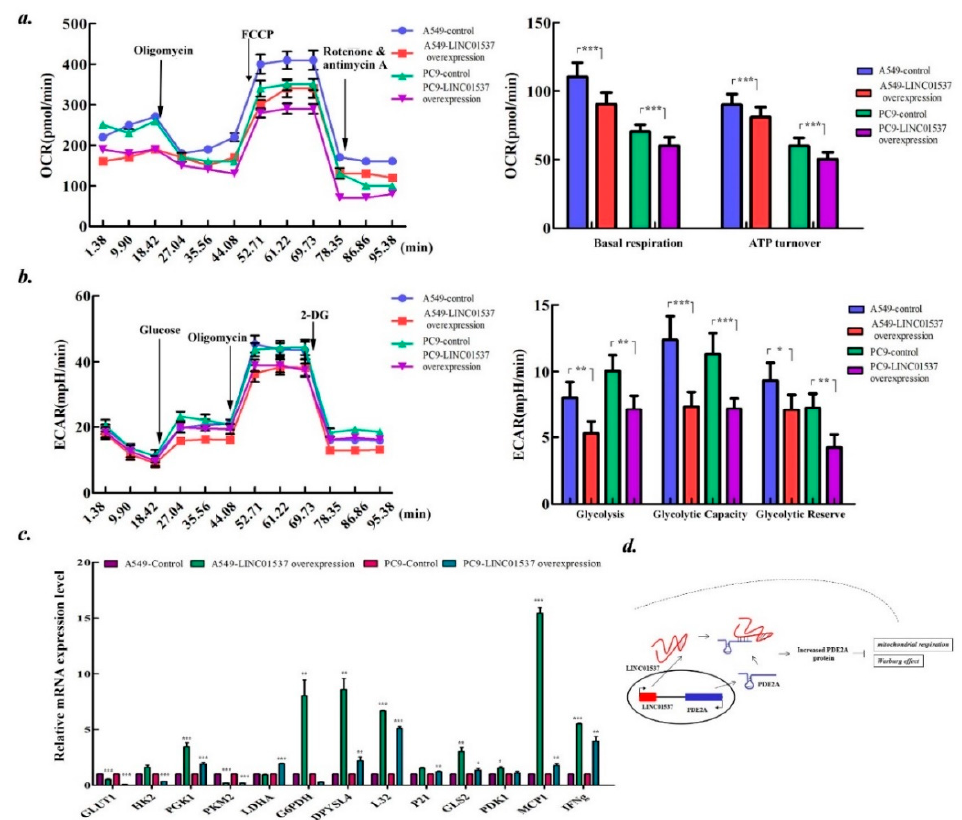
Figure 6. LINC01537 overexpression leads to attenuated Warburg effect and mitochondrial respiration. a-b. The Seahorse XF Glycolysis Stress Test Kit was used to determine oxygen consumption rate (OCR) ( a ) and extracellular acidification rate (ECAR) ( b ). ( c ) . The diagram shows the genes involve tumor energy metabolism which are induced by LINC01537 overexpression. d. A model depicts the regulatory mechanism of LINC01537 on PDE2A and energy metabolism. Bar height on line corresponds to the mean, and error bars represent the SD for five (a, b) or three ( c ) biological replicates.